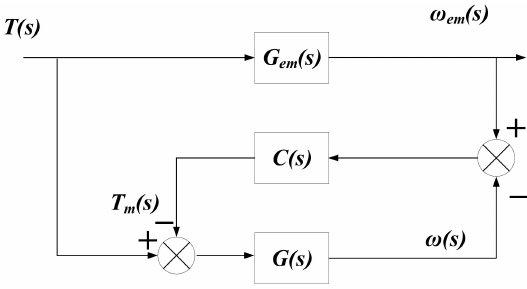
Figure 19. Forward speed tracking